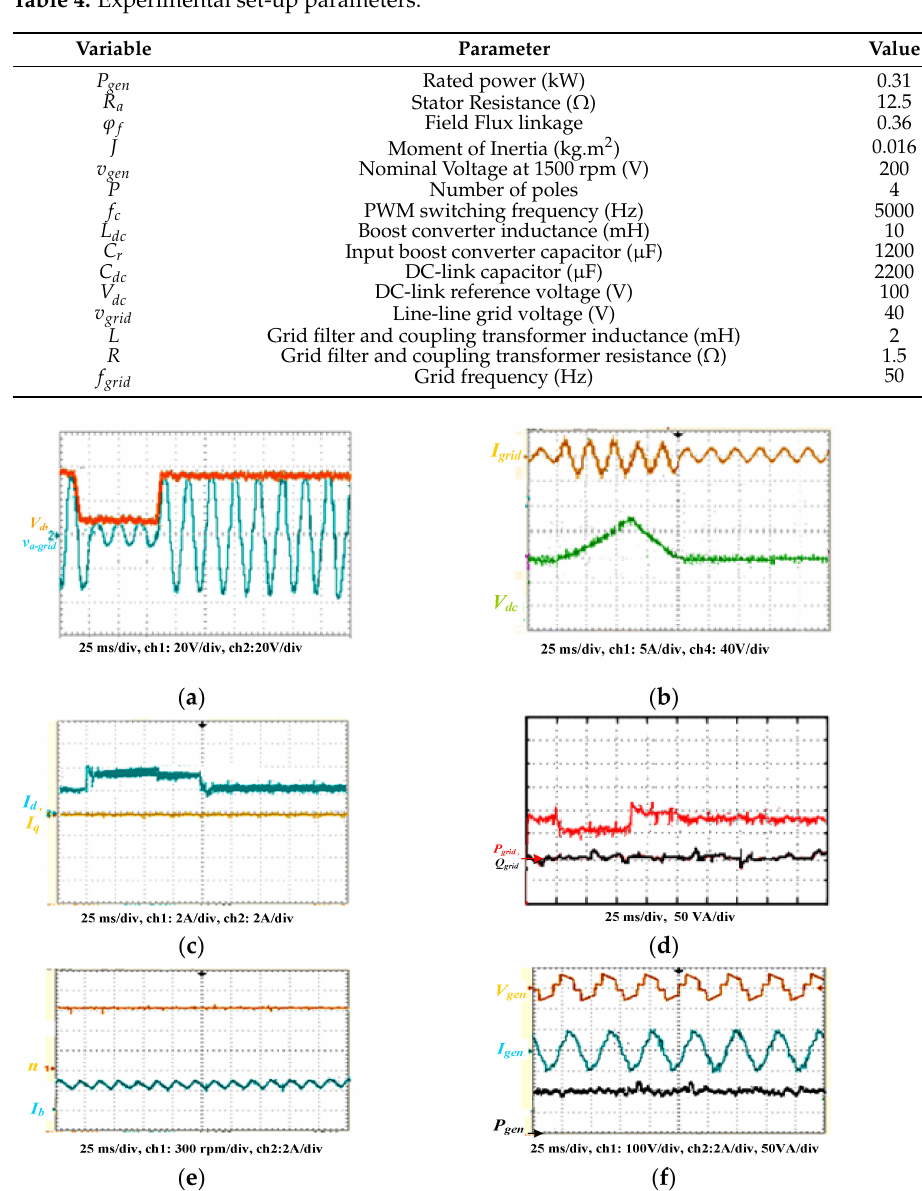
Figure 13. Experimental results during 70% symmetrical grid voltage dip without the proposed control scheme: ( a ) phase ‘a’ grid voltage v grid and d-axis grid voltage V d ; ( b ) phase ‘a’ grid current i grid and DC-link voltage V dc ; ( c ) d- and q-axis grid currents I d and I q ; ( d ) grid active power P grid and reactive power Q grid ; ( e ) Boost chopper current I b and PMSG speed n ; ( f ) PMSG Line-line voltage v ab − gen , phase a-current i a − gen and active power P gen